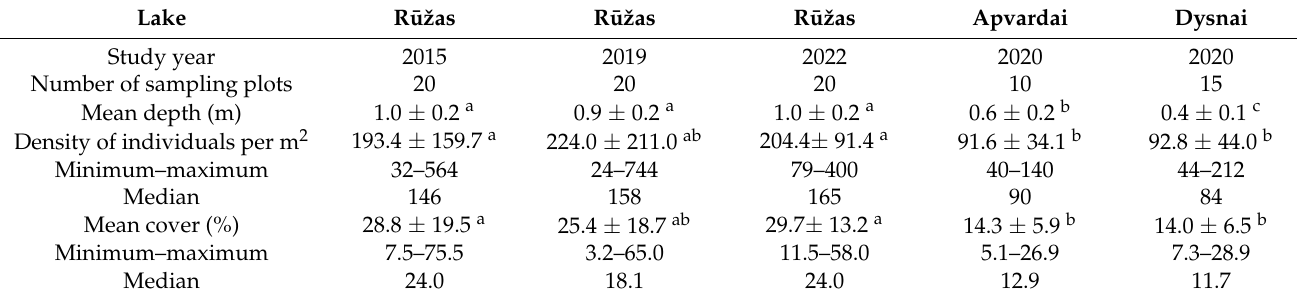
Table 4. Characteristics of sampling plots and descriptive statistics of Aldrovanda vesiculosa density and cover in different years and lakes (mean ± SD, minimum and maximum values, median). Different lower-case letters in superscript indicate significant differences across rows according to Mann–Whitney pairwise comparison.